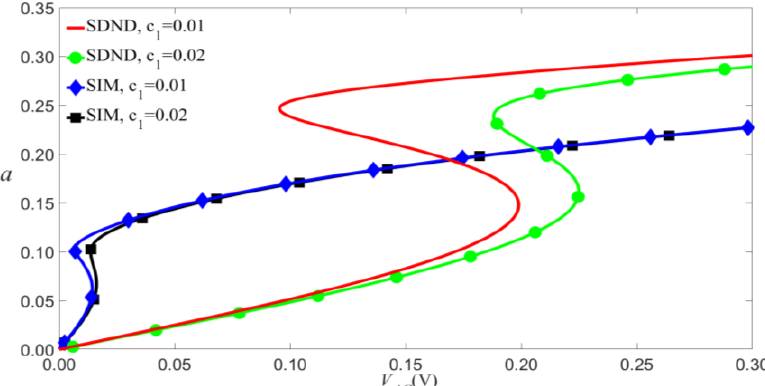
Figure 9. Amplitude of the response as a function of the load’s amplitude of primary resonance for V DC = 4 V, P 0 = 0.01 N, and σ =